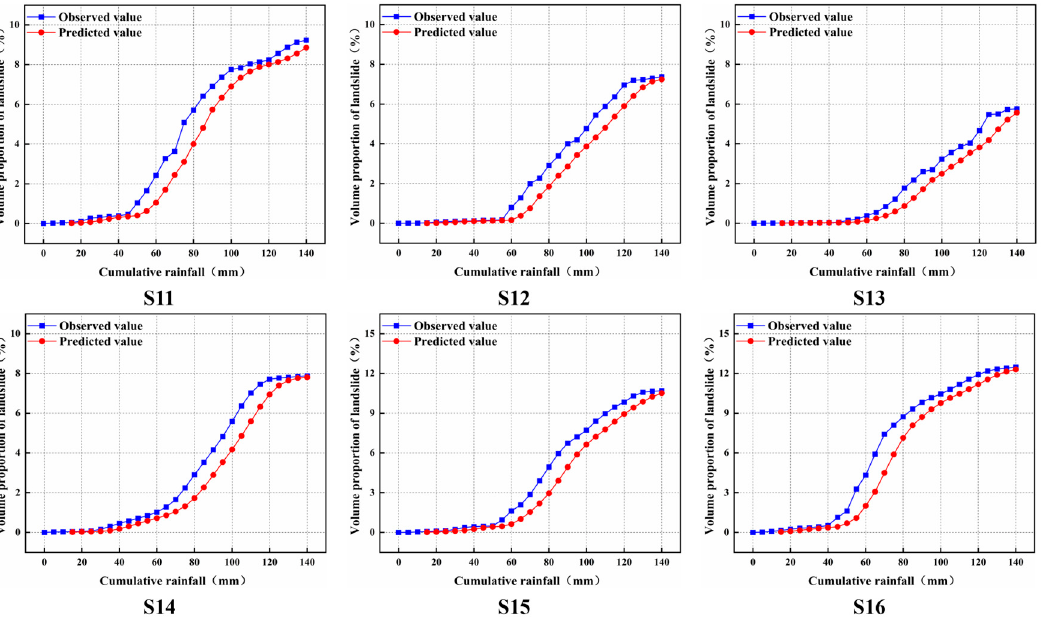
Figure 7. Types of spatial damage to landslides.